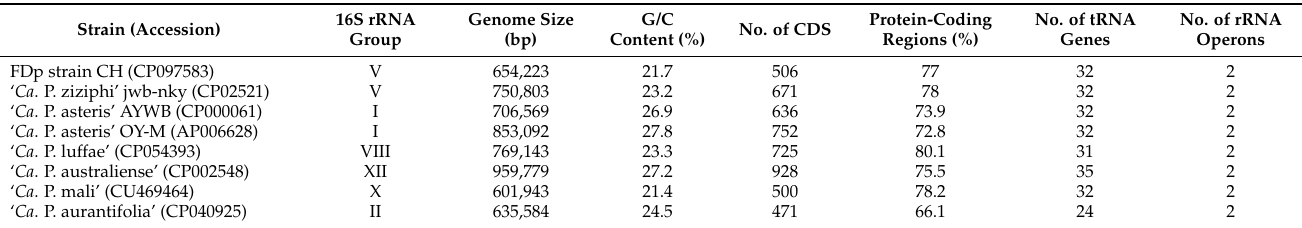
Table 1. General characteristics of FDp strain CH and comparison to representative complete phyto- plasma